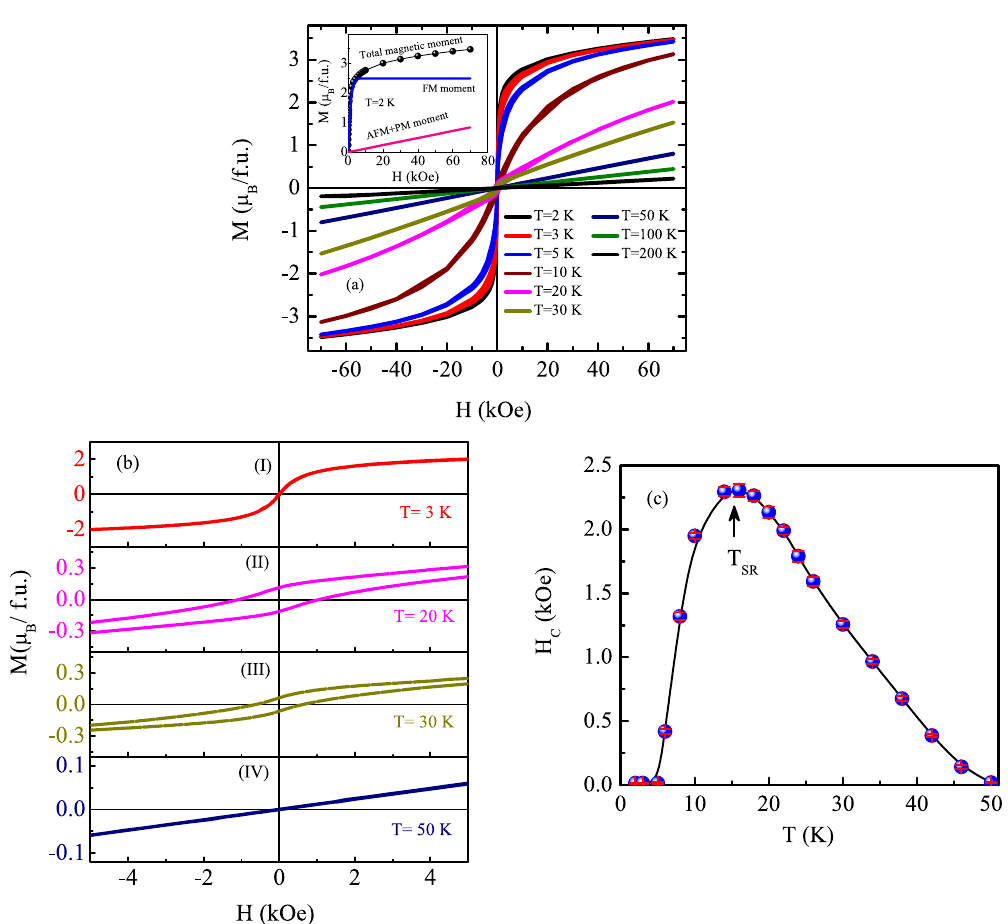
Figure 8. (a) Magnetic field dependence of magnetization at different temperatures. Inset shows the isothermal magnetization curve at T = 2K along with the estimated FM and AFM/PM contributions. (b) Low field region of isothermal magnetization at some selected temperatures, T = 3 K (I), 20 K (II), 30 K (III), and 50 K (IV). (c) Temperature dependence of coercive field. Solid line is guide to the